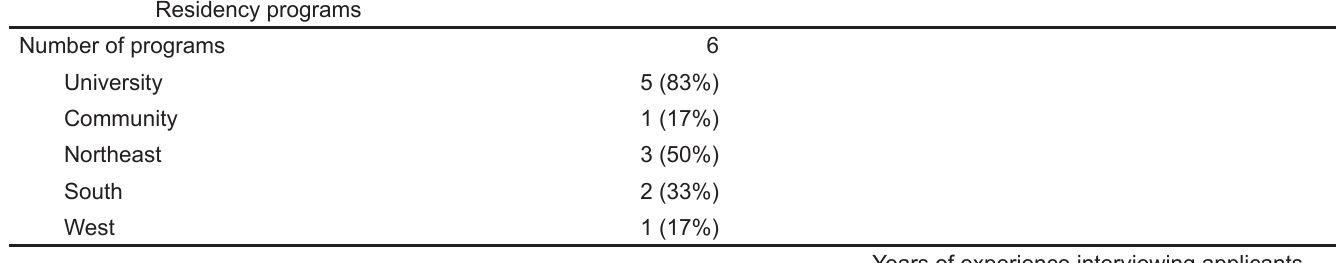
Table 1. Demographic data of residency programs and traditional interviewers.